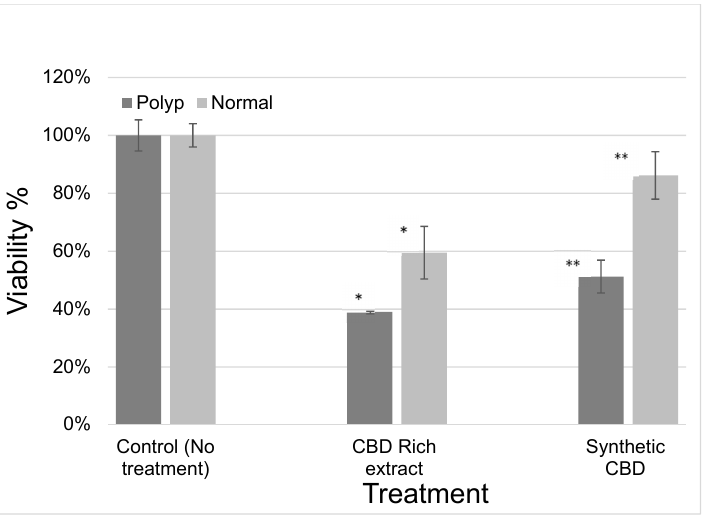
Figure 1. Influence of cannabidiol (CBD) and CBD-rich extract on the viability of polypoid cells and adjacent normal colonic cells. CBD-rich extract had a similar effect as synthetic CBD. * p < 0.03, ** p < 0.02.